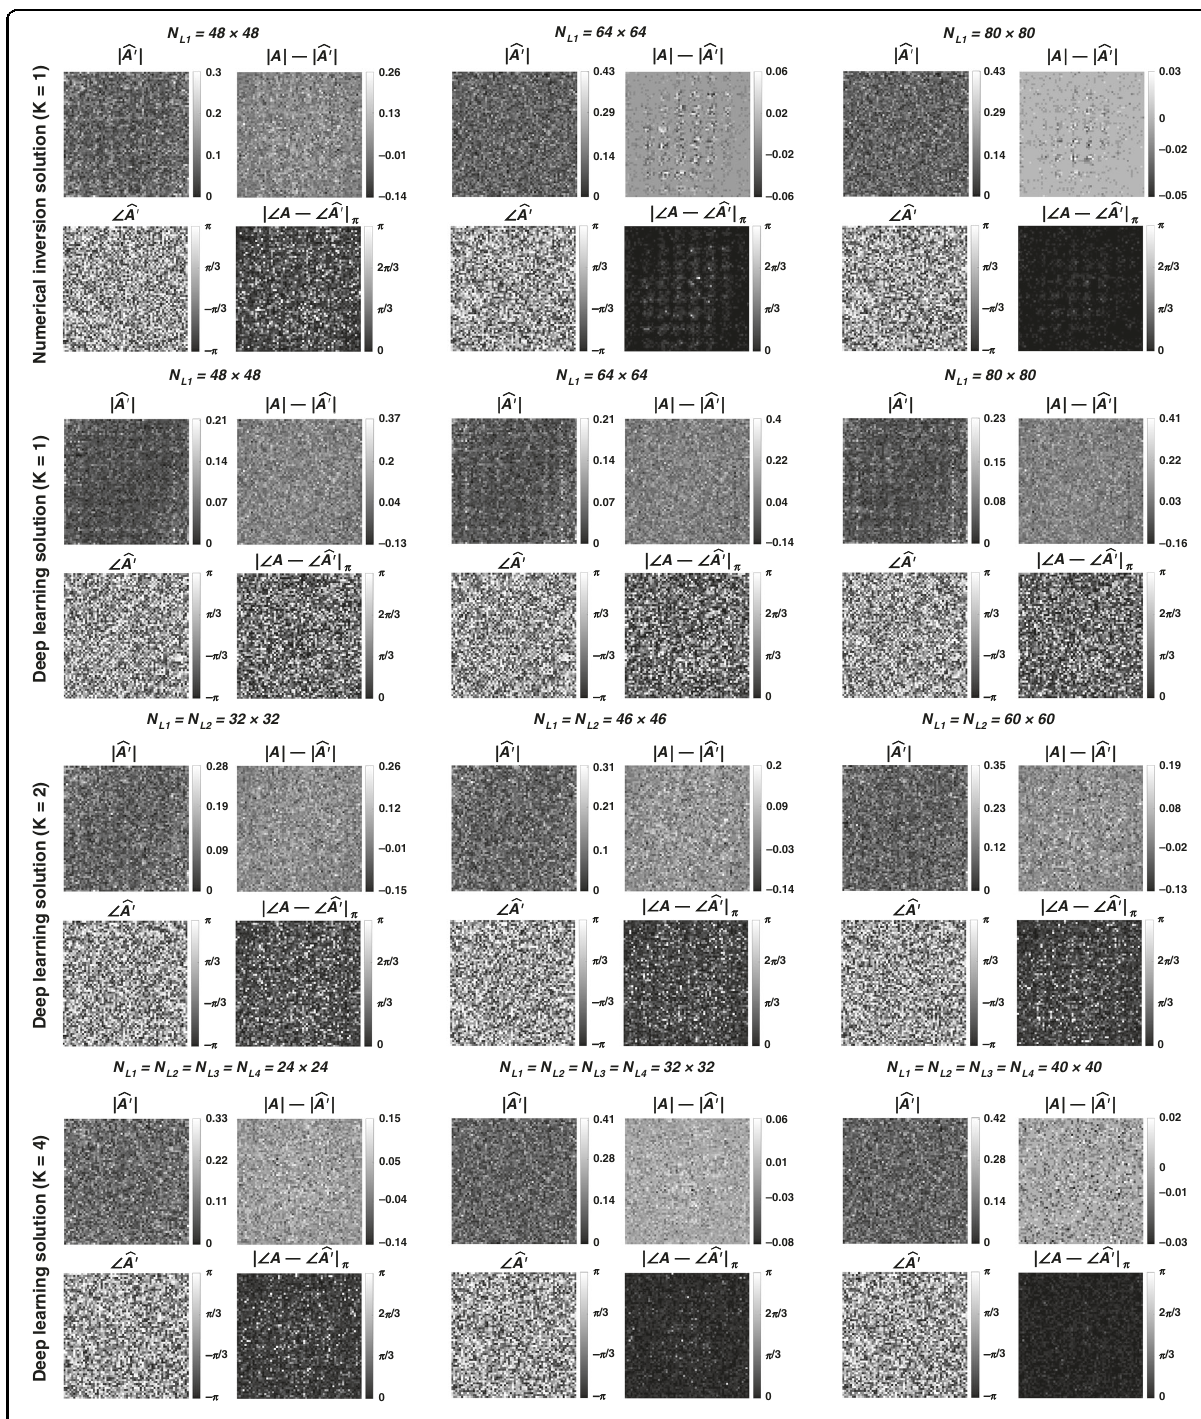
Fig. 2 Diffractive all-optical transformations and their differences from the ground truth, target transformation ( A ) presented in Fig. 1b. (cid:5) (cid:5) (cid:5) (cid:5) (cid:5) (cid:5) indicates the wrapped phase difference between the ground truth and the normalized all-optical ff A (cid:2) ff b A ′ π